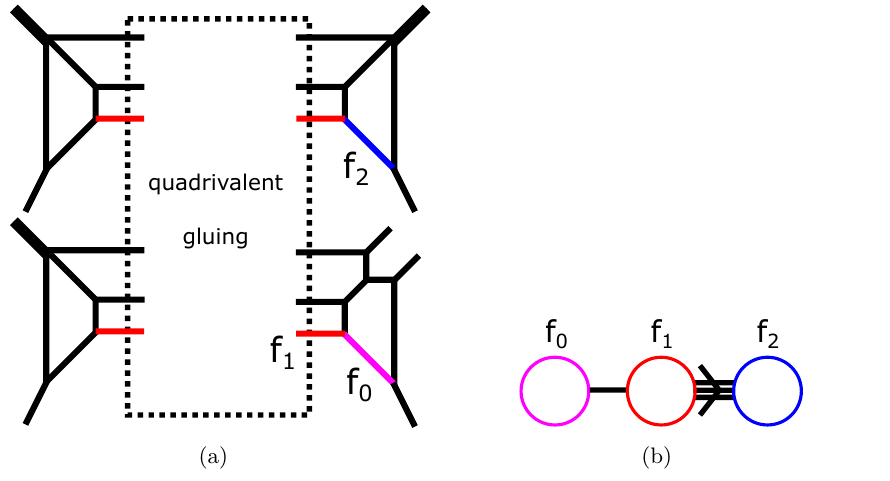
Figure 7. (a): The web diagram of the theory obtained after the Higgsing (2 , 2 , 2 , 0) . (b): The Dynkin diagram of the affine Lie algebra g (1) . The lines in red, blue and magenta in figure 7(a) 2 correspond to the nodes in red, blue and magenta in this figure